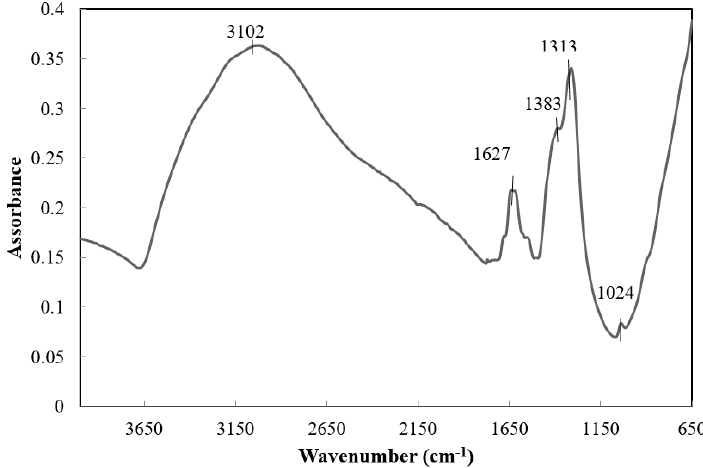
Figure 3. FT-IR spectra of product hydrolyzed for 1 h in the presence of NH 4 OH 1.0 M and subsequently treated for 1 h with 0.1 M HNO 3 .